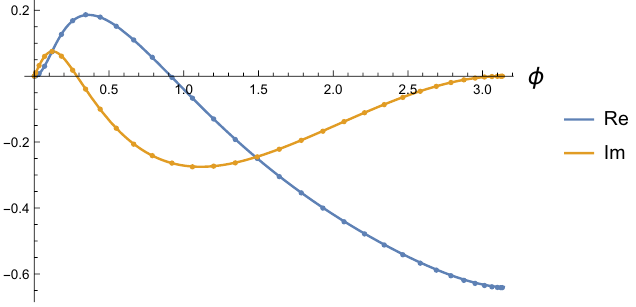
Figure 9 . The real and imaginary parts of the form factor of the stress-tensor found numerically in the E 8 model. The dots correspond to the trace of the stress-tensor form factor de(cid:12)ned in (5.26). The plot is constructed with N max =